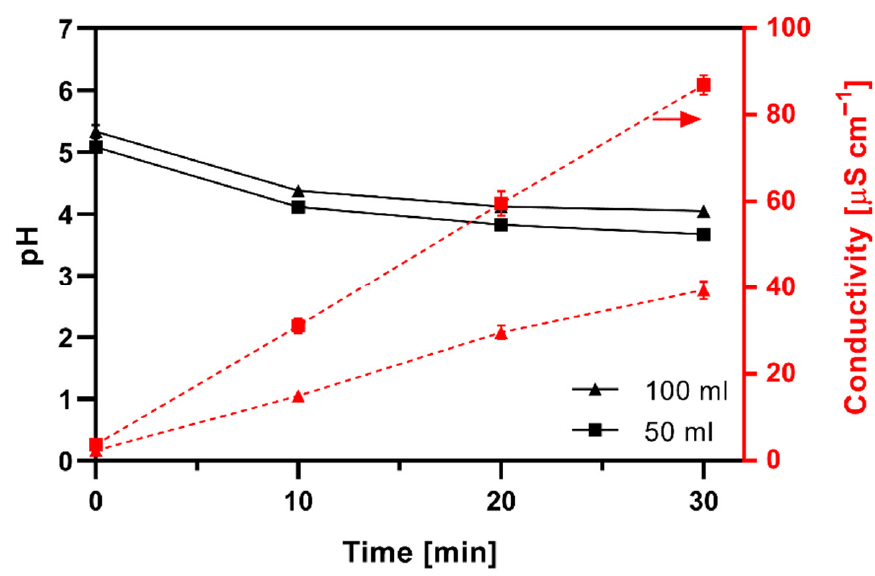
Figure 3. Variation of pH and electrical conductivity of PAW as a function of treatment time (min) with plasma for two sample volumes (50 and 100 mL). Two-way ANOVA, p < 0.05.